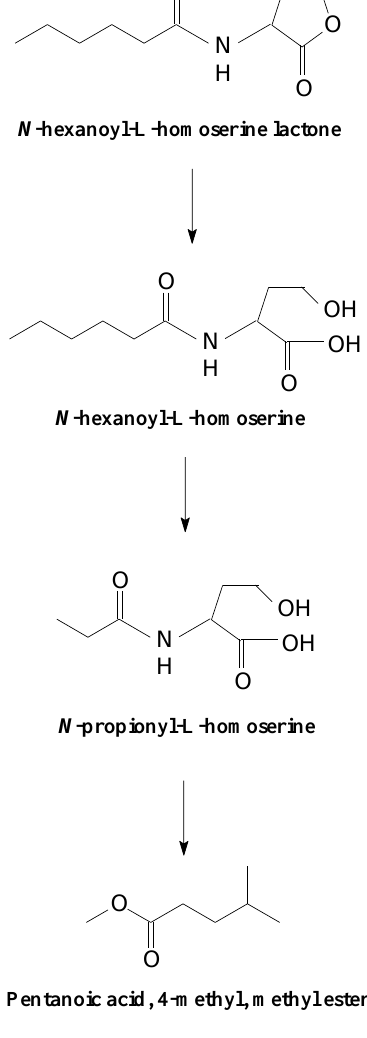
Figure 9. Proposed N -acyl-homoserine lactone (AHL) degradation pathway in strain XN-10.